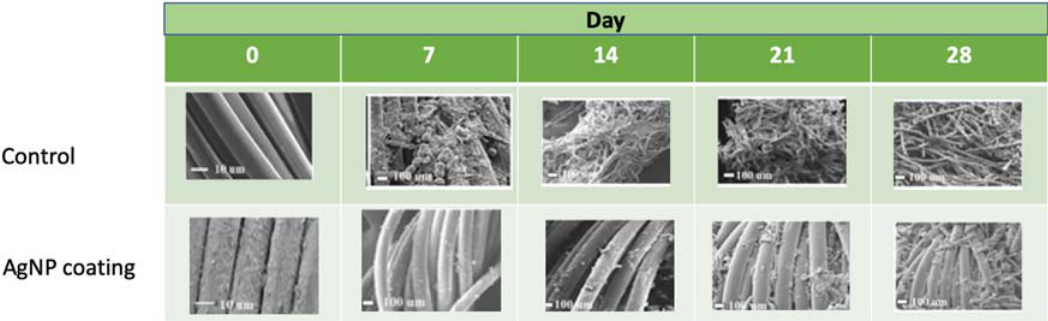
Figure 5: ZnO e ff ect on bio fi lm adhered onto the fi shing net [ 102 ]